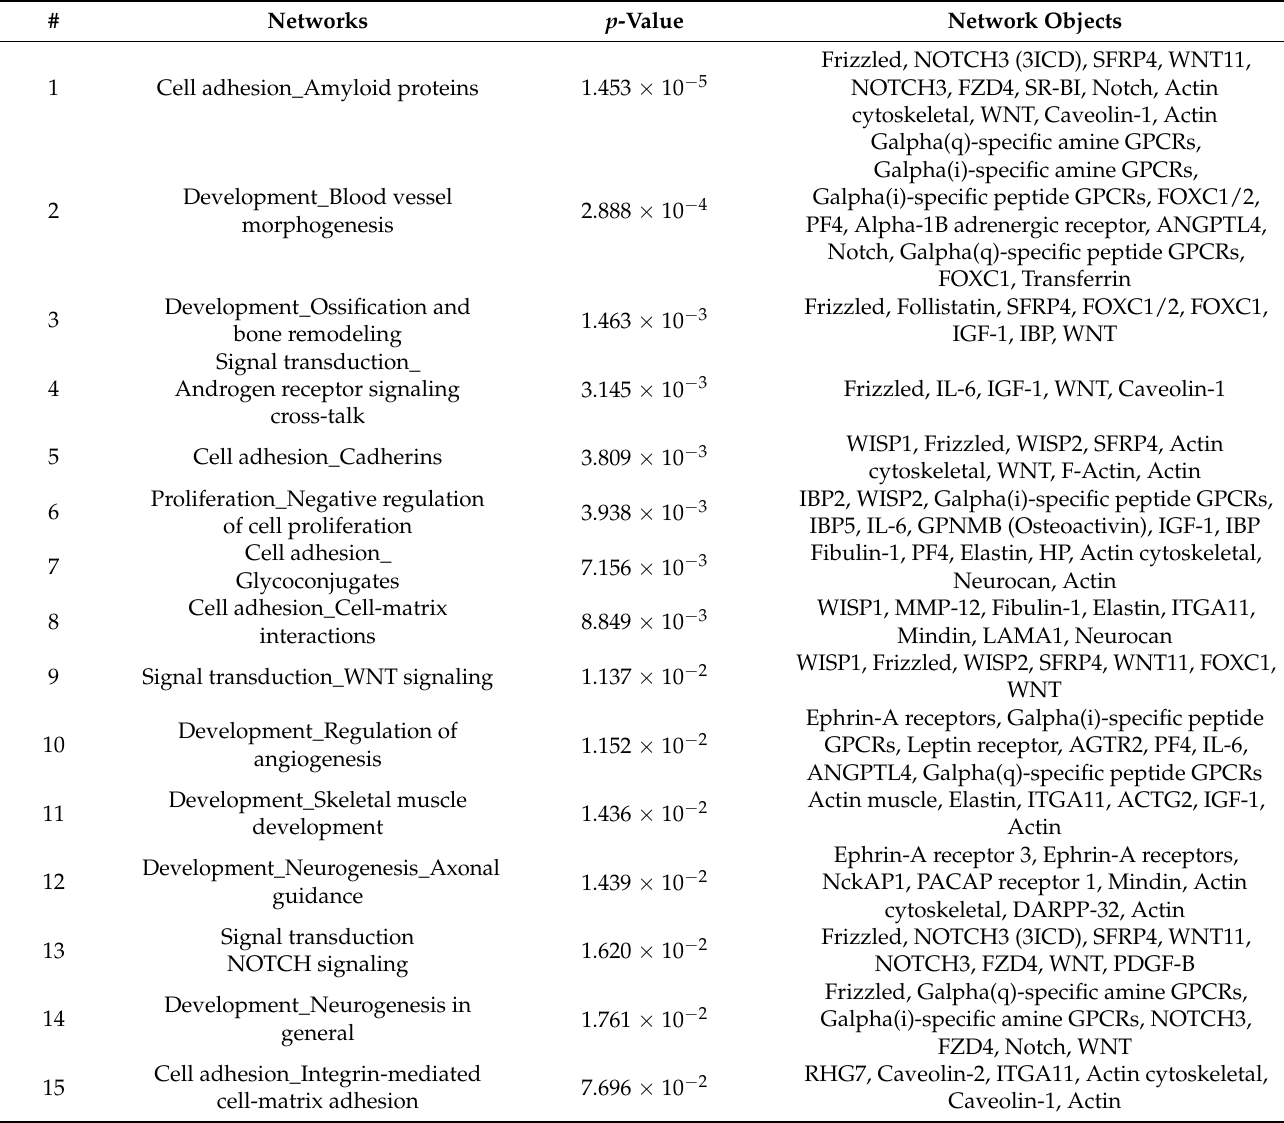
Table 2. Enrichment analysis by process network of differentially expressed genes between WT and Abcd1 − /y SGCs in RNA-seq using metacore bioinformatics